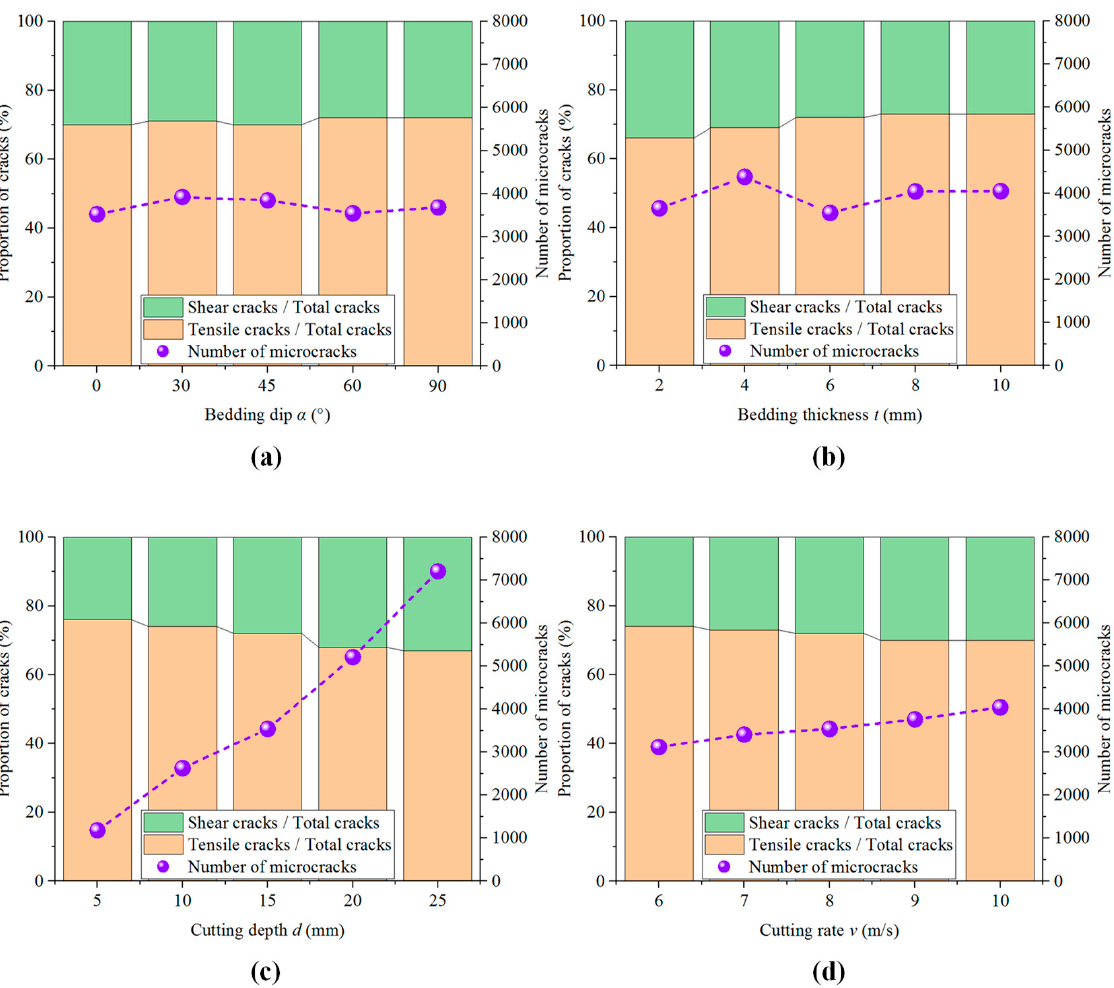
Figure 25. Under the same cutting displacement, the change in the proportion of tension cracks and shear cracks in the sample, and the number of total cracks with different levels of various factors. ( a ) Effect of bedding dips on proportion of cracks; ( b ) effect of bedding thicknesses on proportion of cracks; ( c ) effect of cutting depths on proportion of cracks; ( d ) effect of cutting rates on proportion of cracks.